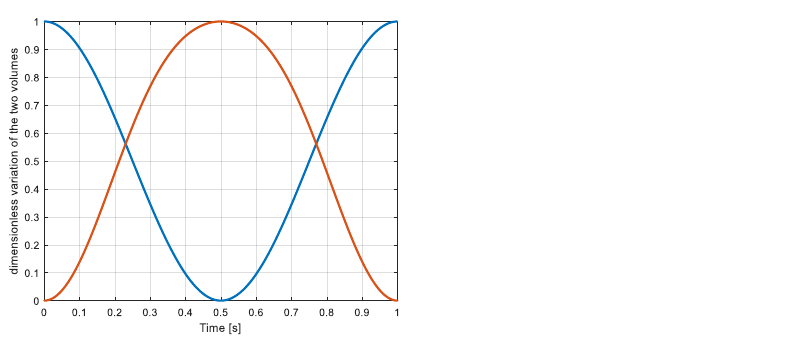
Figure 7. Dimension-less variation of the volumes of the compression cylinders. (red: left, blue: right) The curves represent already the asymmetric variation of the volumes of the left and right compression cylinders due to properties of the used crankshaft and 180° shifted